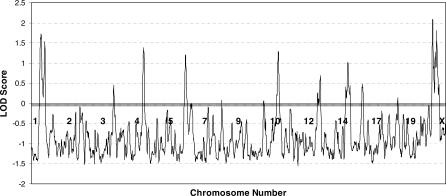
Genome-Wide Admixture Scans of a Total of 1,670 Participants with HTN and 387 Control Participants from GCI+MEC Do Not Reveal a Locus for Hypertension RiskThe GCI+MEC combined scan yielded top LOD scores of 2.1 and 1.8 for peaks at Xp22 and Xp11 respectively, with a genome-wide score of −0.03.